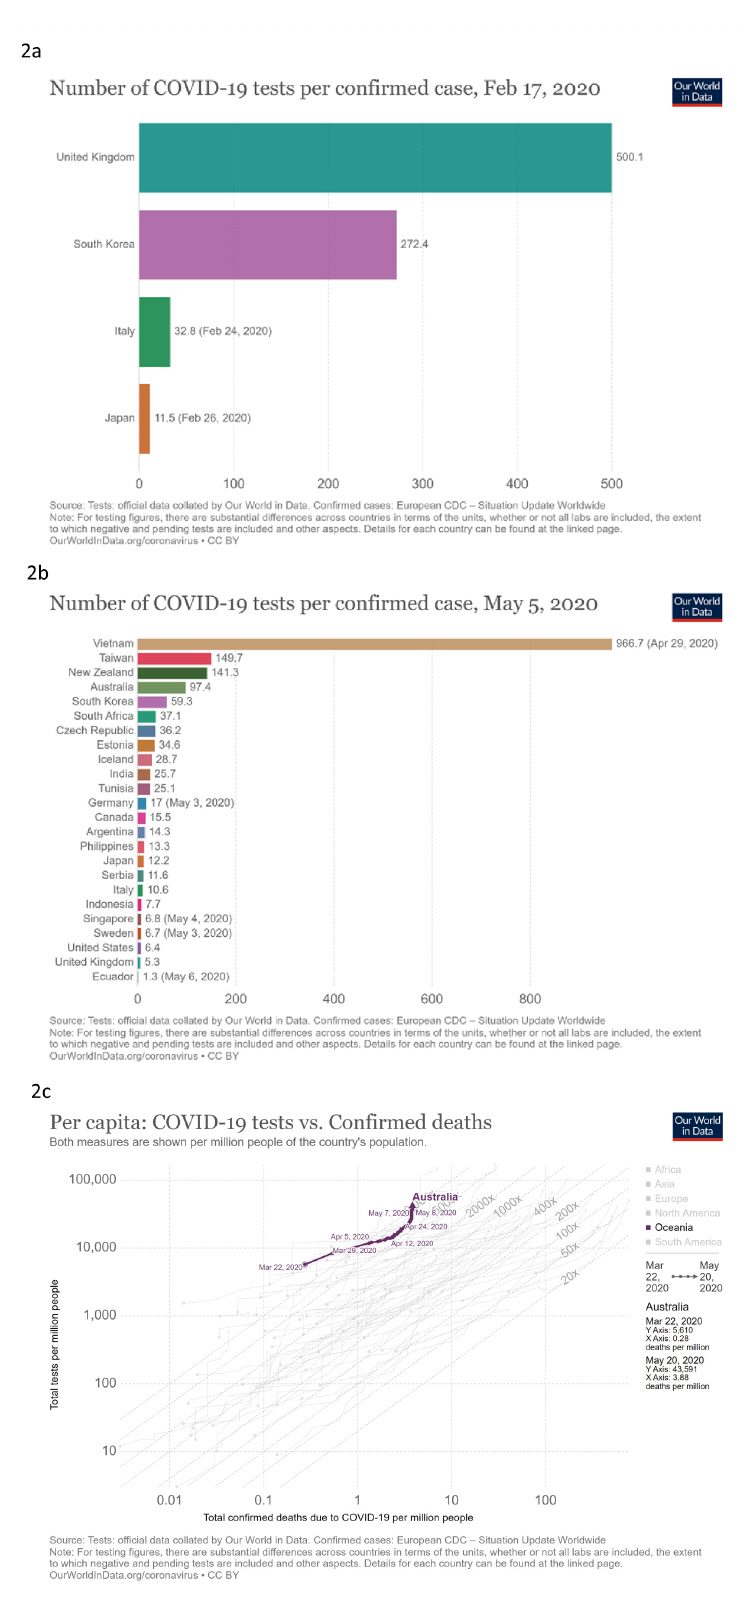
Figure 2. Detect. These graphs show a ) total COVID-19 tests per 1,000 people b ) number of COVID-19 tests per confirmed case of COVID-19 c ) total COVID-19 tests compared to confirmed deaths with COVID-19 per million people. Updated graphs can be found here, here and